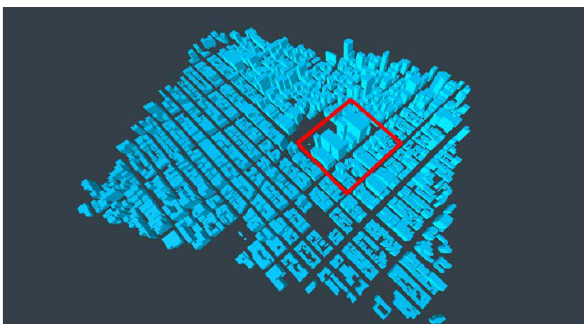
Figure 3 Virtual 3D LOD1 model of New-York city with the analysis zone